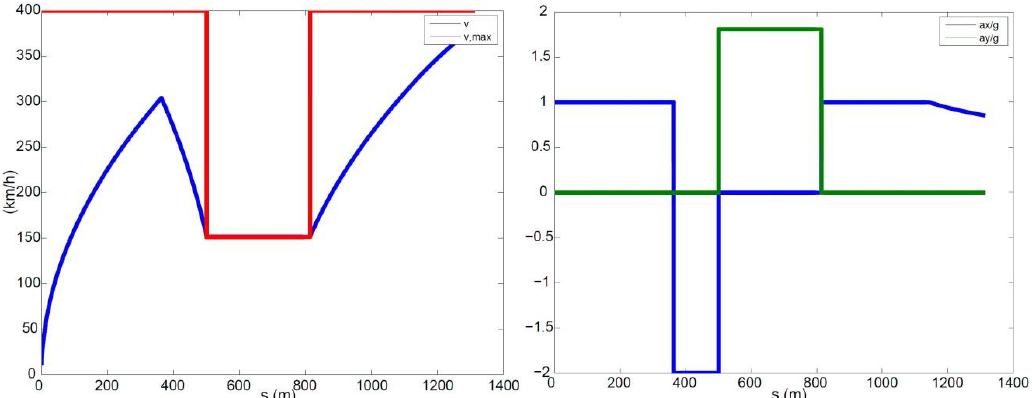
Figure 10. Straight lines and hairpin bend path.